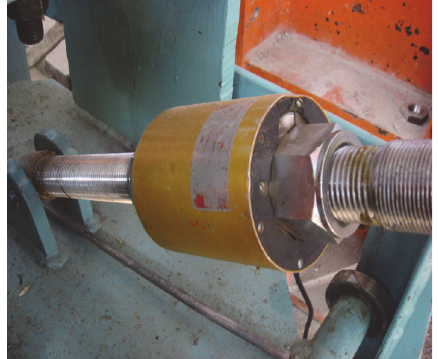
Figure 8: Pressure sensor.